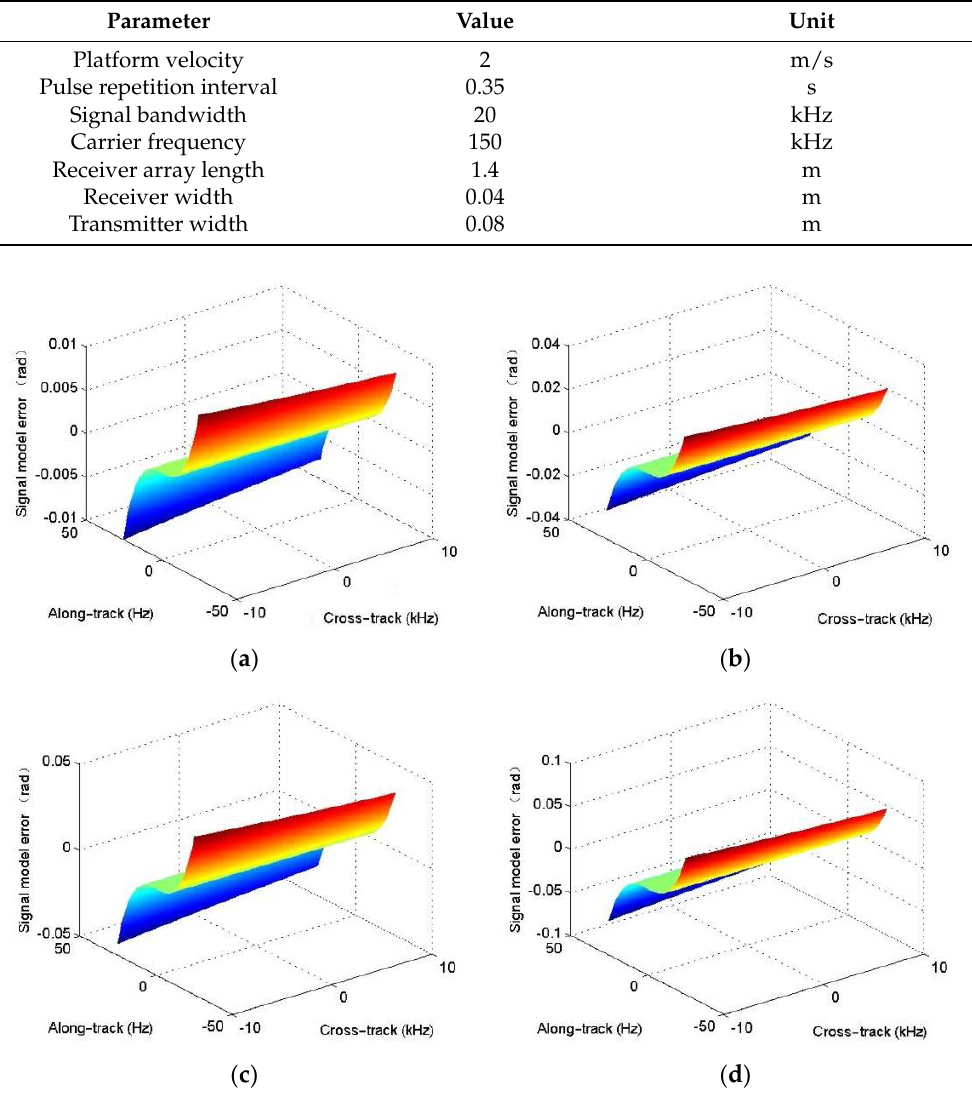
Figure 2. Signal model error for the first transmitter/receiver pair when the system works with narrow-bandwidth. ( a ) r = 40 m; ( b ) r = 110 m; ( c ) r = 180 m; ( d ) r = 250 m.